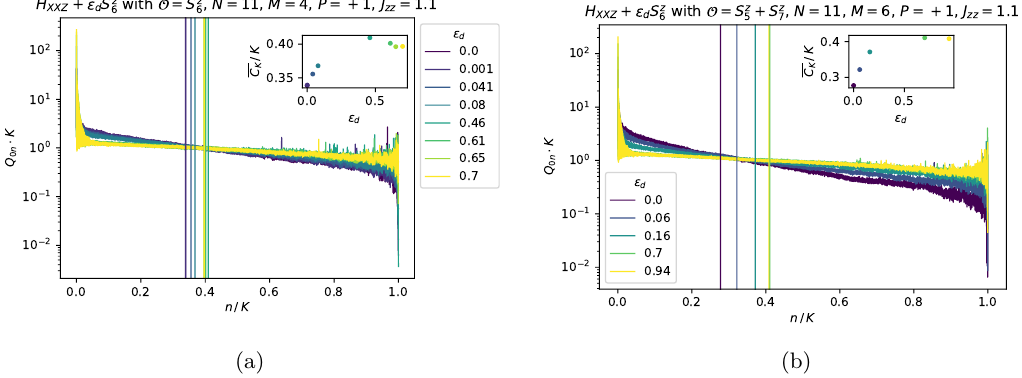
Figure 4. Late-time transition probability results for local operator of the form (3.5) with trace removed, for H with an H integrability-breaking term. The vertical lines represent the late- XXZ d time saturation value of KC as a fraction of the Krylov space dimension. Left: for N = 11 spins in the sector M = 4 , P = +1 with J = 1 . 1 for the operator O = S z . The Krylov space dimension is zz 6 K = 28731 . Right: for N = 11 spins in the sector M = 6 , P = +1 with J zz = 1 . 1 for the operator + S z . For this system the Krylov space dimension is K = 55461 . Inset: dependence of KC O = S z 5 7 saturation value on the strength of the integrability-breaking